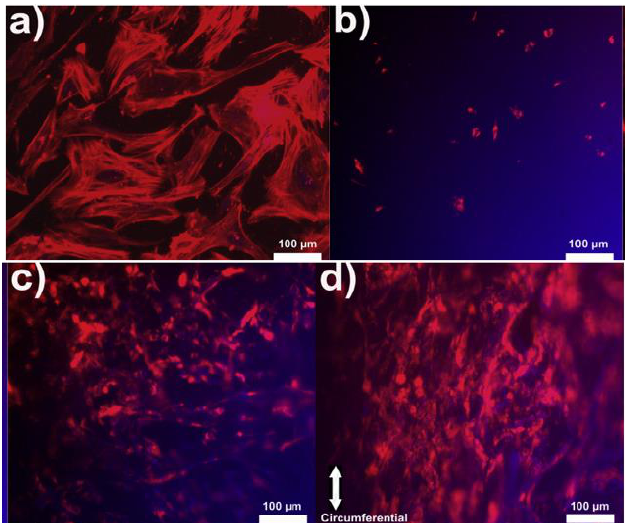
Figure 11. Representative images depicting the cell-scaffold interactions. DiI-DAPI stained hVICs on ( a ) glass coverslip, ( b ) DBP, ( c ) Bio-hybrid R and ( d ) Bio-hybrid A scaffolds; (Dil: 1,1′ -dioctadecyl- 3,3,3′,3′ -tetramethylindocarbocyanine perchlorate; DAPI: 4′,6 -diamidino-2-phenylindole). Adapted with permission from ref. [169]. Copyright 2016, Elsevier.